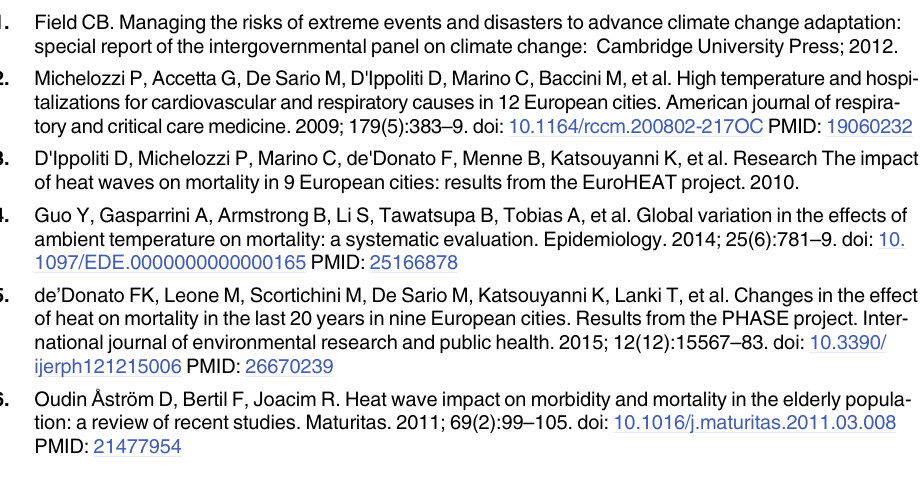
S1 Table. Daily maximum temperatures for the summer months over the period 1997 – 2013 per meteorological